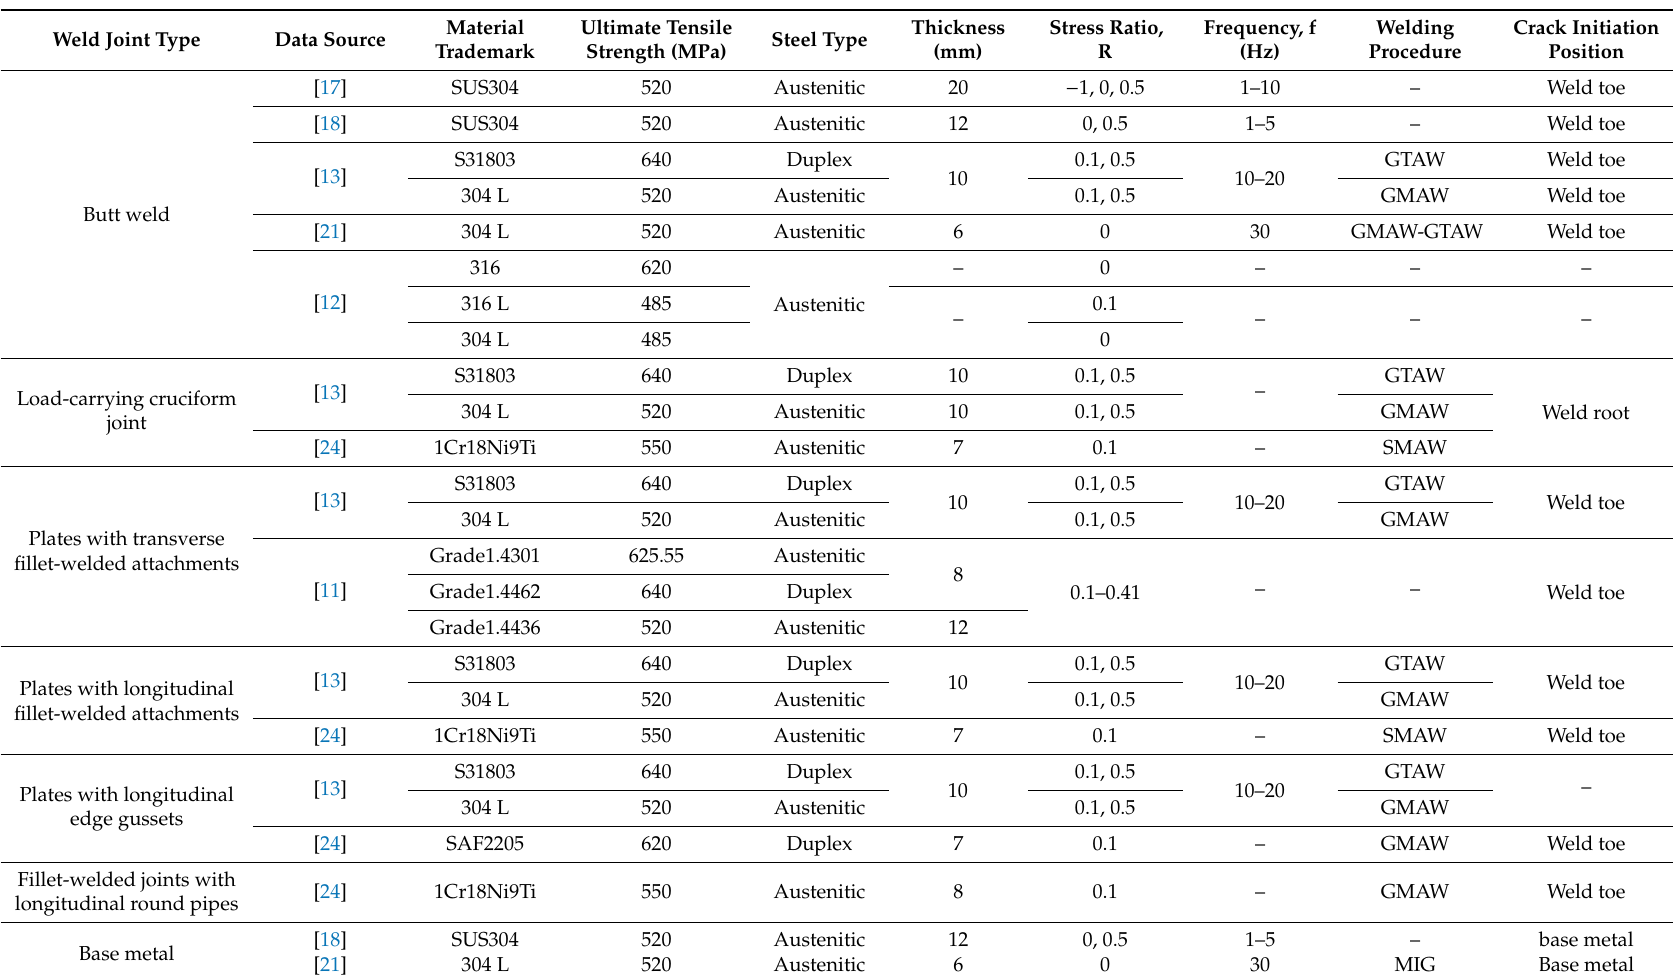
Table 2. Fatigue test data for stainless